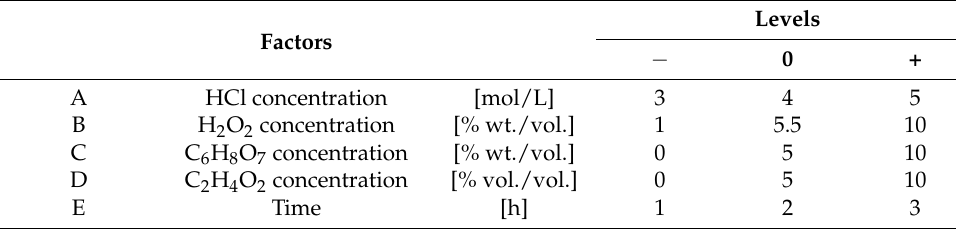
Table 2. Factors and levels for Pd and Pt recovery from SAC.